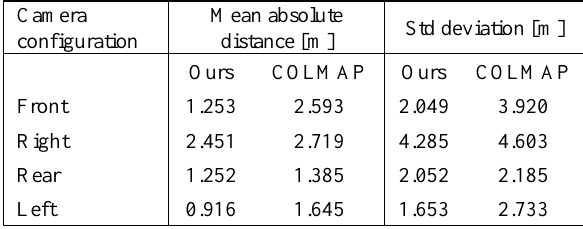
Table 3 . Statistics of dense reconstruction accuracy for different mounting configurations of monocular cameras (Experiment